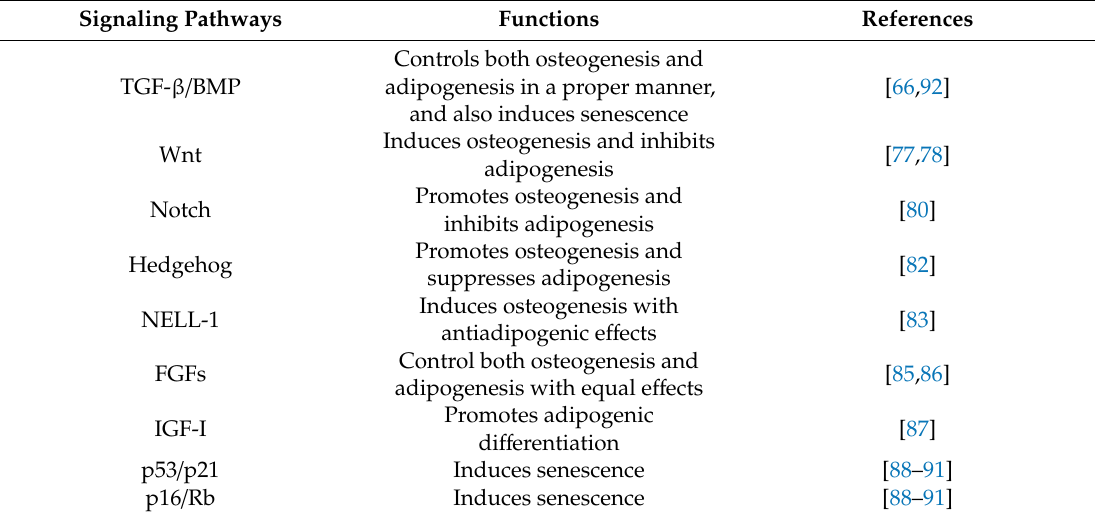
Table 2. Signaling pathways involved in di ff erentiation and senescence of